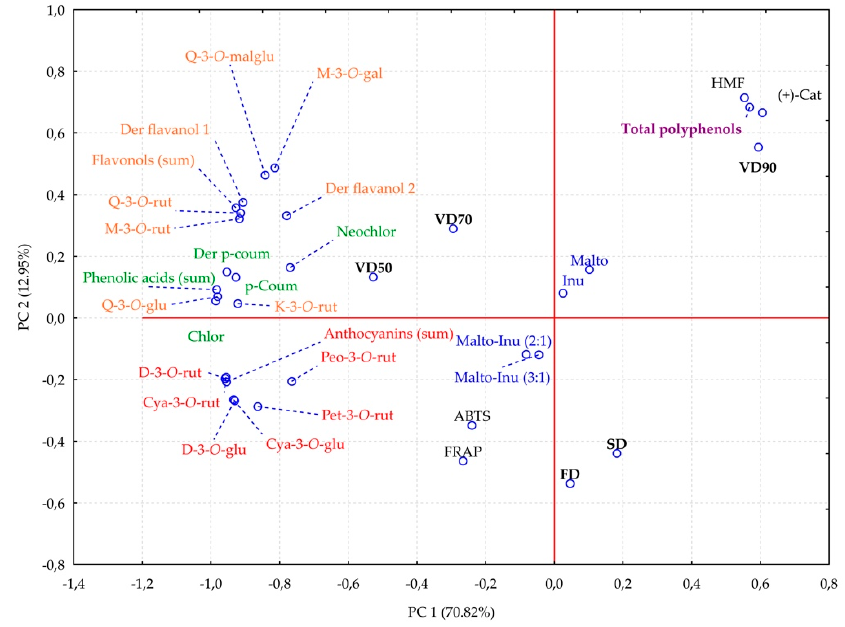
Figure 1. The principal component analysis (PCA) for drying methods (FD—freeze-drying; VD— Figure